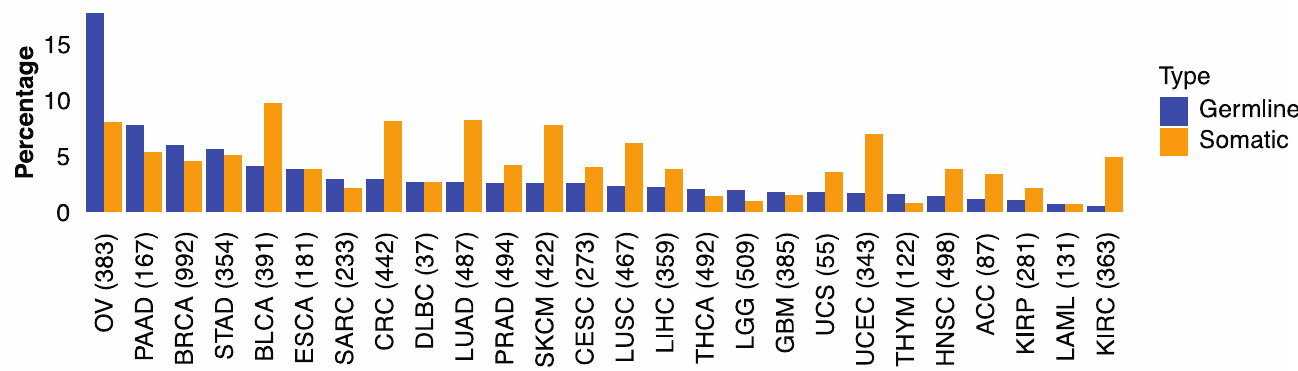
Figure 1. The percentage of germline and somatic Homologous Recombination mutations in 32 TCGA cancer types. The proportion of TCGA cases within each cancer type carrying germline variants (blue) or somatic mutations (orange) in 30 HR genes.